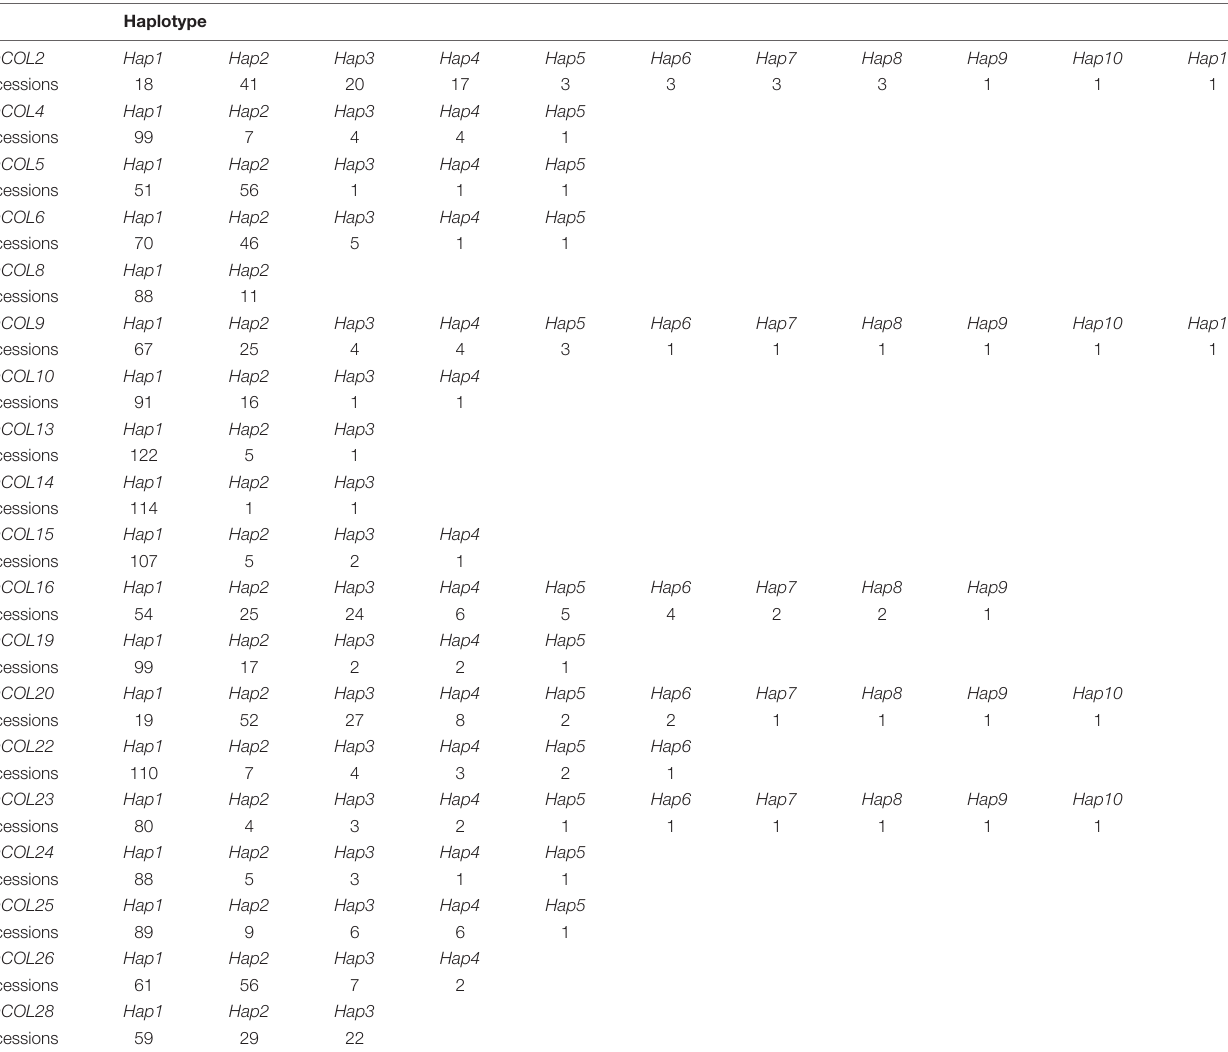
TABLE 3 | Haplotype frequency of GmCOL family